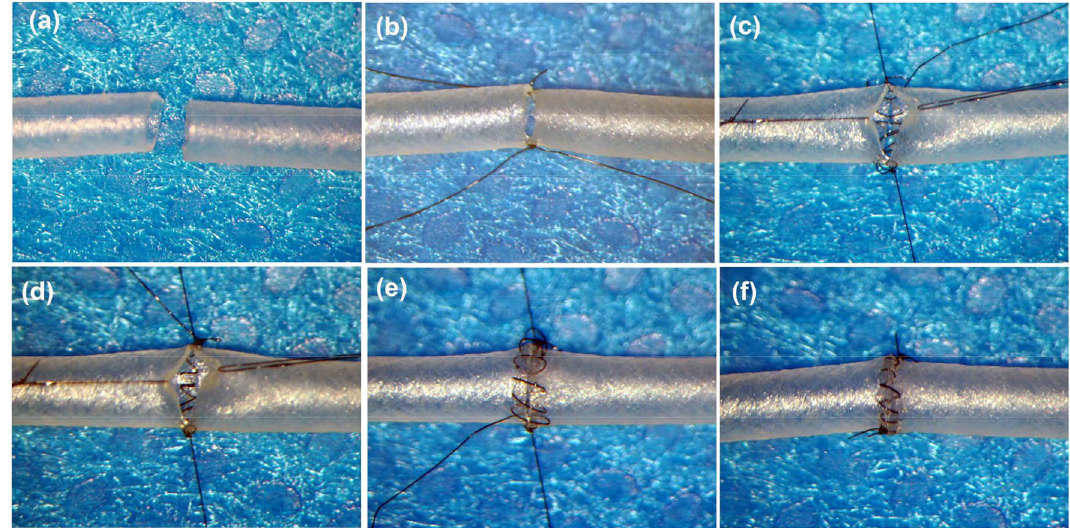
Figure 4. End-to-end anastomosis by using silicone tube. Both ends of the silicone tube was trimmed ( a ). Two anchoring sutures were placed ( b ). The posterior wall was closed intraluminally in a loose continuous suturing technique loosely ( c ) and tightened ( d ). The anterior wall was closed extraluminally in a loose continuous suturing fashion ( e ) and these sutures were tightened ( f ).